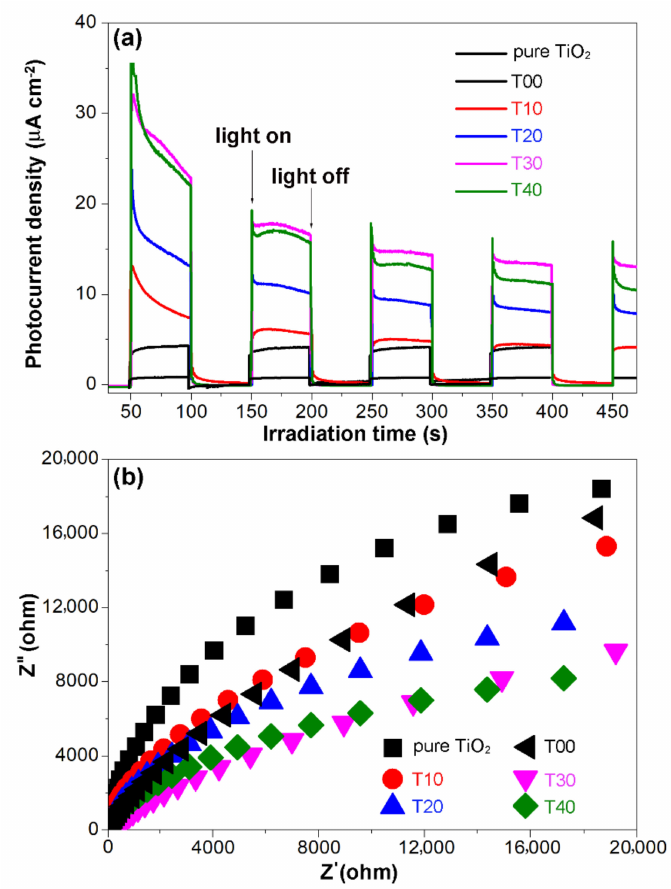
Figure 6. Transient photocurrent response ( a ) and EIS spectrum ( b ) of Nyquist plots acquired at open-circuit potential exposed to visible light illumination for different samples.